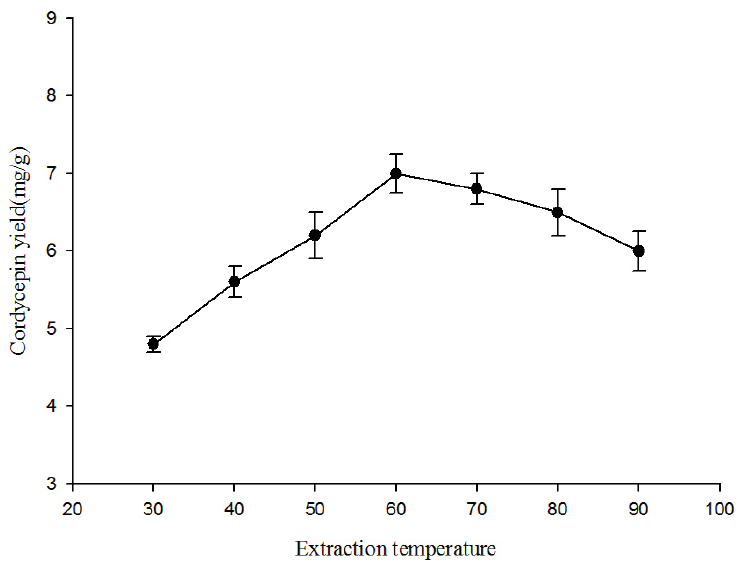
Figure 4. Effect of extraction temperature (°C) on the extraction yield of cordycepin from C. militaris . Extraction time: 50 min; ethanol concentration: 50%; ratio of liquid to solid: 20 mL/g; extraction frequency: 40